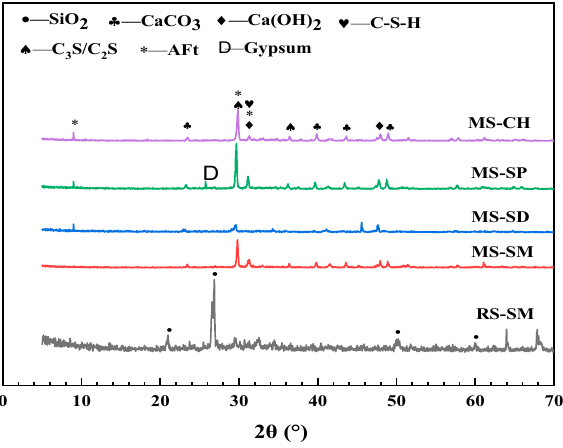
Figure 11. XRD diffraction patterns of manufactured sand UHPC under different curing methods.